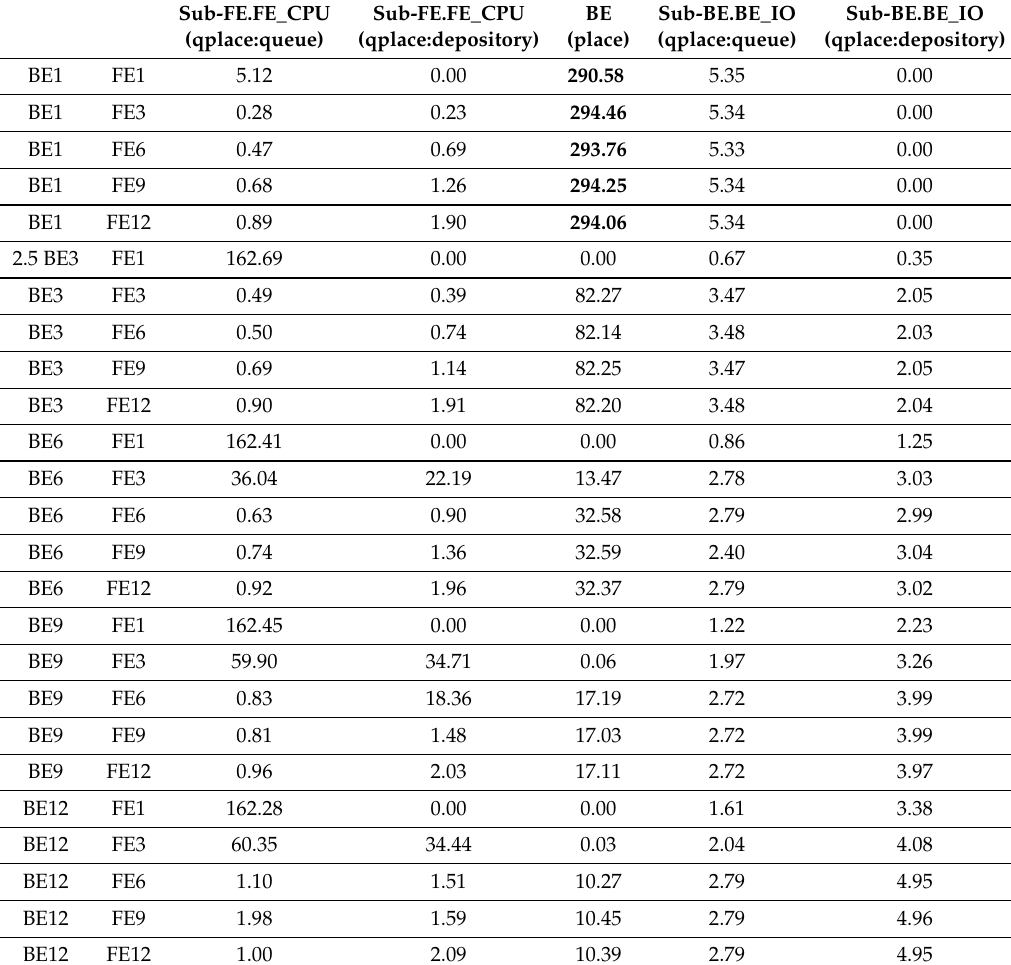
Table 2. Case with parameters: 3000 threads per FE node, 40 database connections per BE